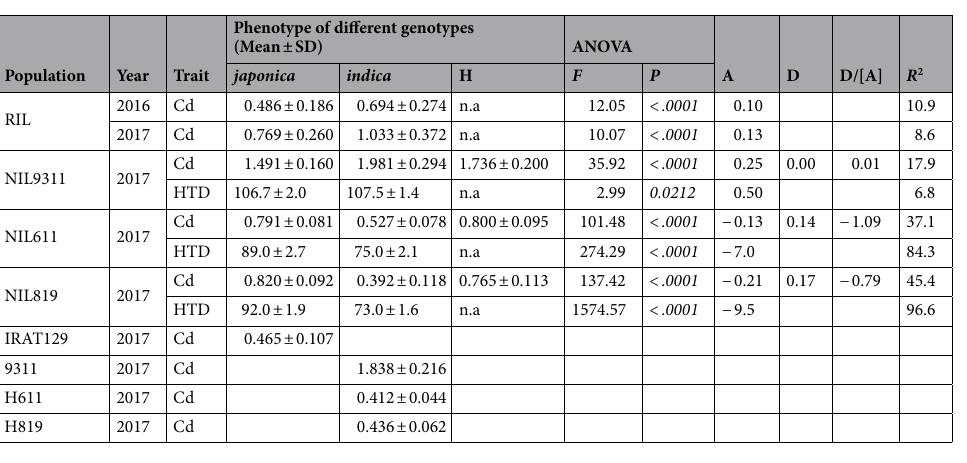
Table 3. Brown rice Cd concentration and HTD of different genotypes differing in the OsHMA3-OsNramp5- OsNramp1 region. HTD is the days to heading. Japonica and indica are lines carrying homozygous OsHMA3- OsNramp5-OsNramp1 haplotype from IRAT129 and indica variety (9311, H611 or H819), respectively. H, the lines carrying heterozygous OsHMA3-OsNramp5-OsNramp1 haplotype. A, additive effect of replacing OsHMA3-OsNramp5-OsNramp1 ind haplotype with OsHMA3-OsNramp5-OsNramp1 jap haplotype. D, degree of dominance. R 2 , the proportion of phenotypic variance explained by